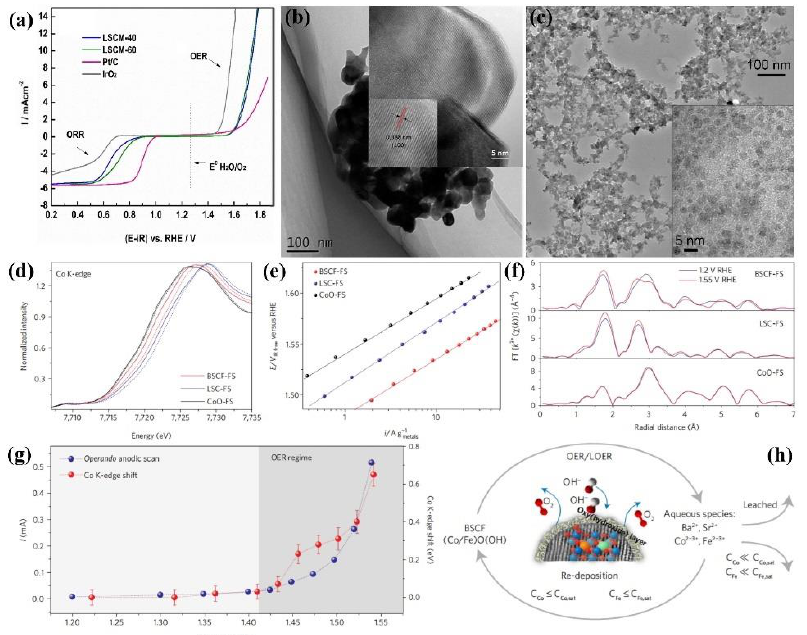
Figure 4. ( a ) ORR and OER polarization curves of LSCM; ( b ) TEM and HRTEM images of LSCM [82]. Copyright 2017, Elsevier Ltd.; ( c ) TEM and HRTEM images of BSCF; ( d ) XANES spectra recorded at the Co K-edge; ( e ) Tafel plots; ( f ) Fourier-transform (FT) of the k 3 -weighted EXAFS records; ( g ) Current and shift of the Co K-edge position records; ( h ) OER/LOER and dissolution/re-deposition mechanism [85]. Copyright 2017, Macmillan Publishers Limited.